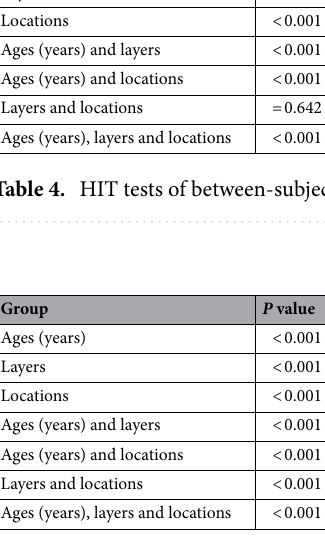
Table 5. E tests of between-subjects effects. R 2 =